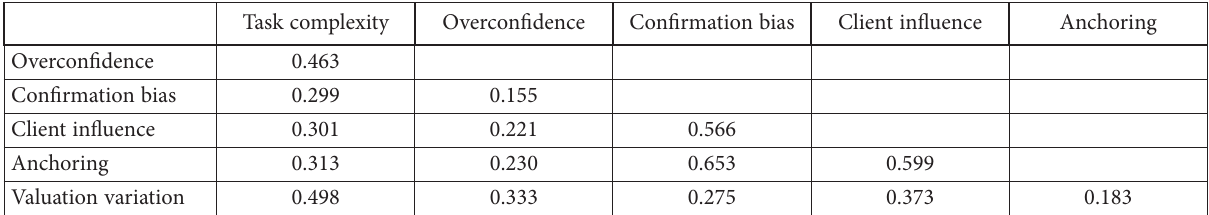
Table 5. HTMT of the latent variables